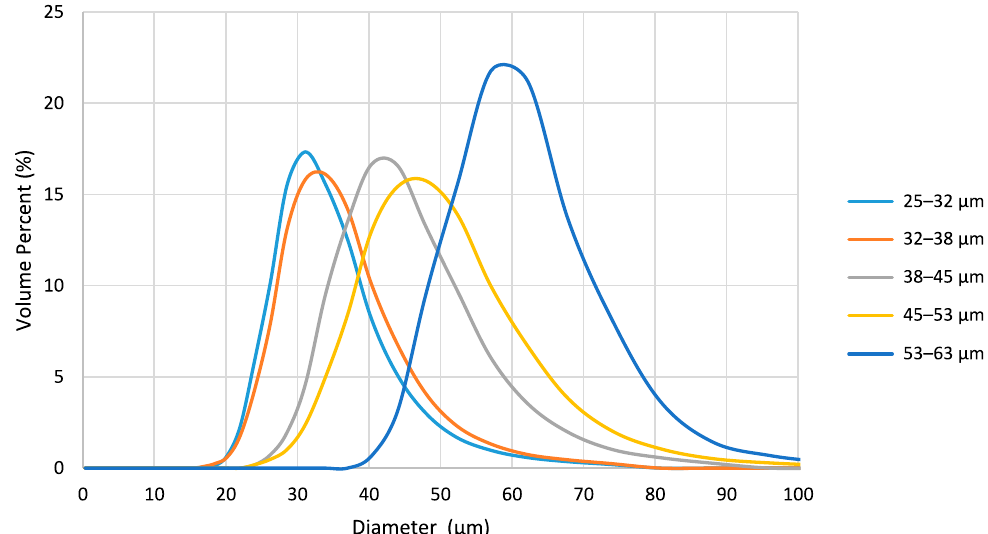
Figure 1. Particle size distribution of the sieved, gas-atomized Al 6061 powder was conducted by laser diffraction analysis. For studying the heat-treated powders, small samples of powder (approximately 30 mg) were thermally processed in a TA Instruments, Inc., (part of Waters Corp. and located in New Castle, DE, USA) Q20 differential scanning calorimeter (DSC). As needed, heat treatment times, temperatures, and heating rates are stated hereafter for each respective sample in the Results and Discussion sections. Still, in DSC analysis, the DSC data were collected with a heating rate of 5 °C min − 1 and scanned from 20-530 °C. The DSC testing atmosphere comprised nitrogen with a flow rate of 50 mL min − 1 . A Tzero Al pan and lid